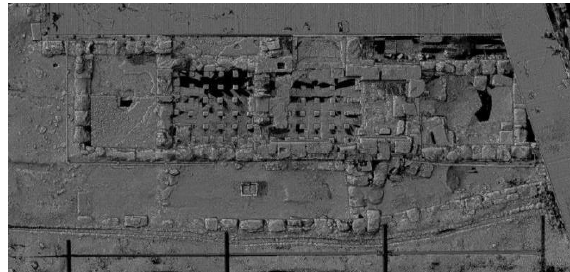
Figure 3. Top view of the 3D Model of the Roman baths area, range based reconstruction.